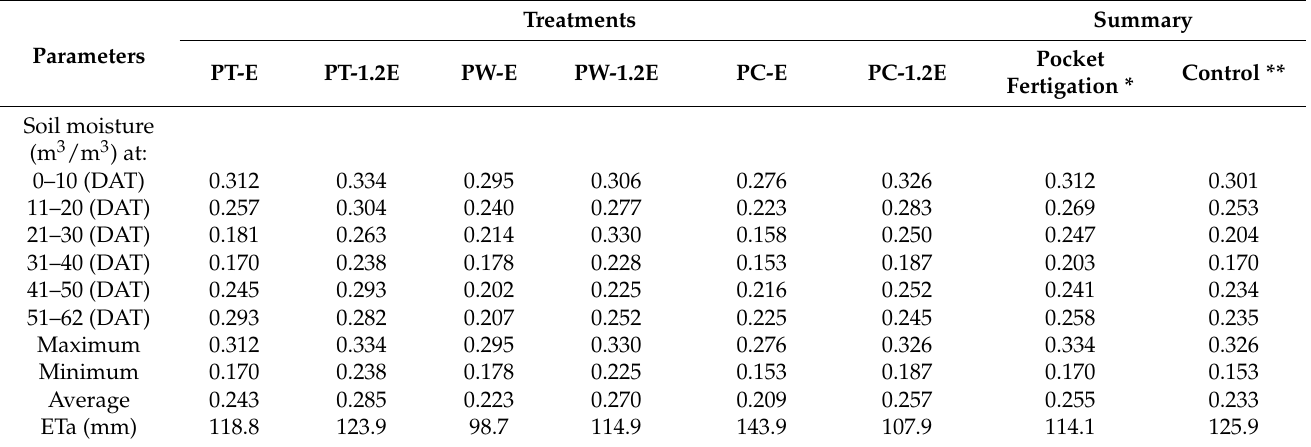
Table 2. The maximum, average, minimum soil moisture, and actual evapotranspiration among the